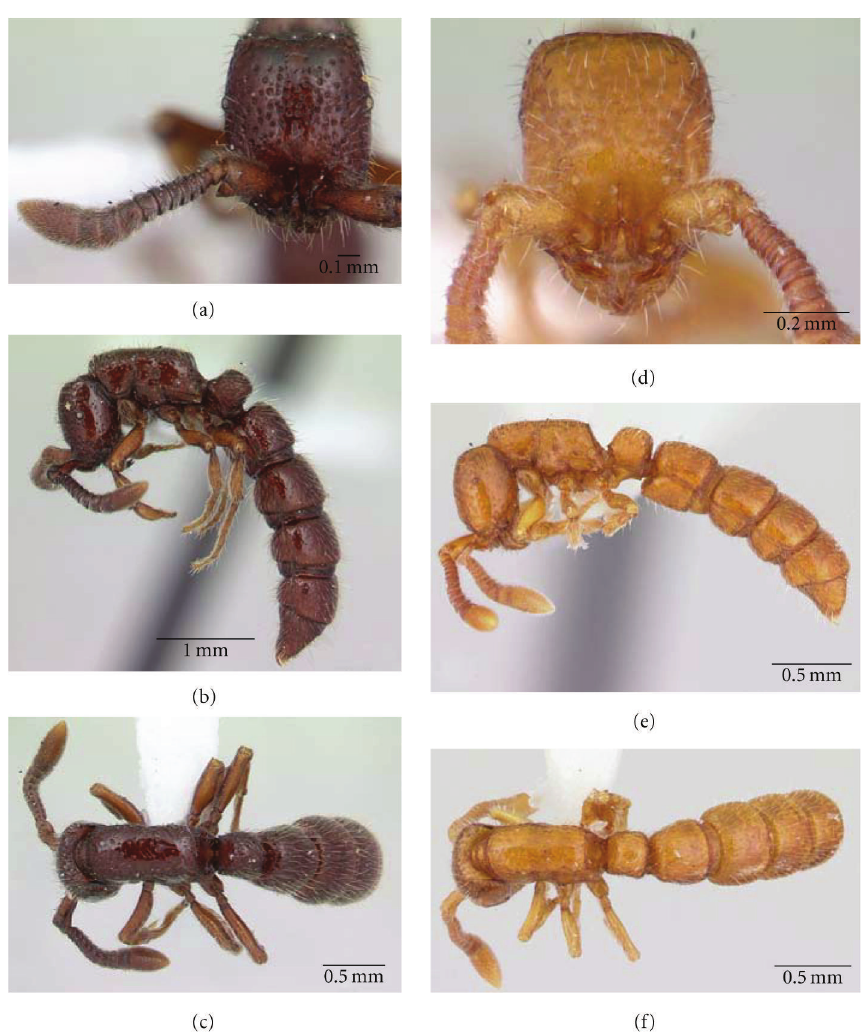
Figure 3: Sphinctomyrmex stali . (a)–(c): worker of morphotype 2 from Ubatuba, SP, Brazil (a) head in full-face view, (b) lateral view, and (c) dorsal view. Image by Michele Esposito, specimen CASENT 0178865. (d)–(f): worker of morphotype 3 from Vic¸osa, MG, Brazil (d) head in full-face view, (e) lateral view, (f) dorsal view. Image by April Nobile, specimen CASENT 0178850.